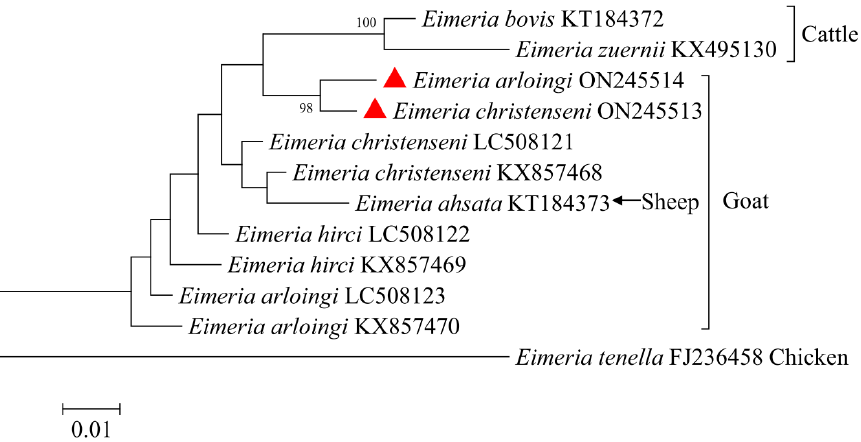
Figure 5. Phylogenetic tree generated by the Neighbor-Joining method using partial sequences of the COI region of E. christenseni and E. arloingi from the present study and representative sequences of other Eimeria species available in GenBank. The sequences obtained in this study are marked with red triangles (bootstrap values below 75% are not indicated). Table 3. Pairwise identities (%) among the COI sequences of E. christenseni and E. arloingi , E. ahsata , and E. hirci .